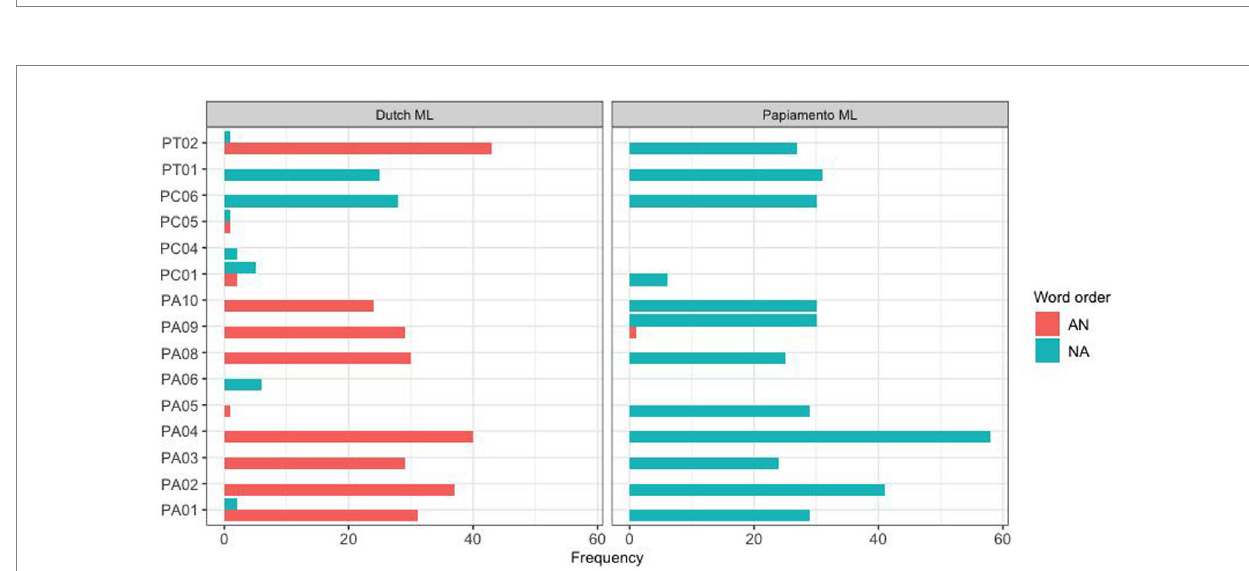
FIGURE 4 Word order production pattern for individual Papiamento HSs, separated by the